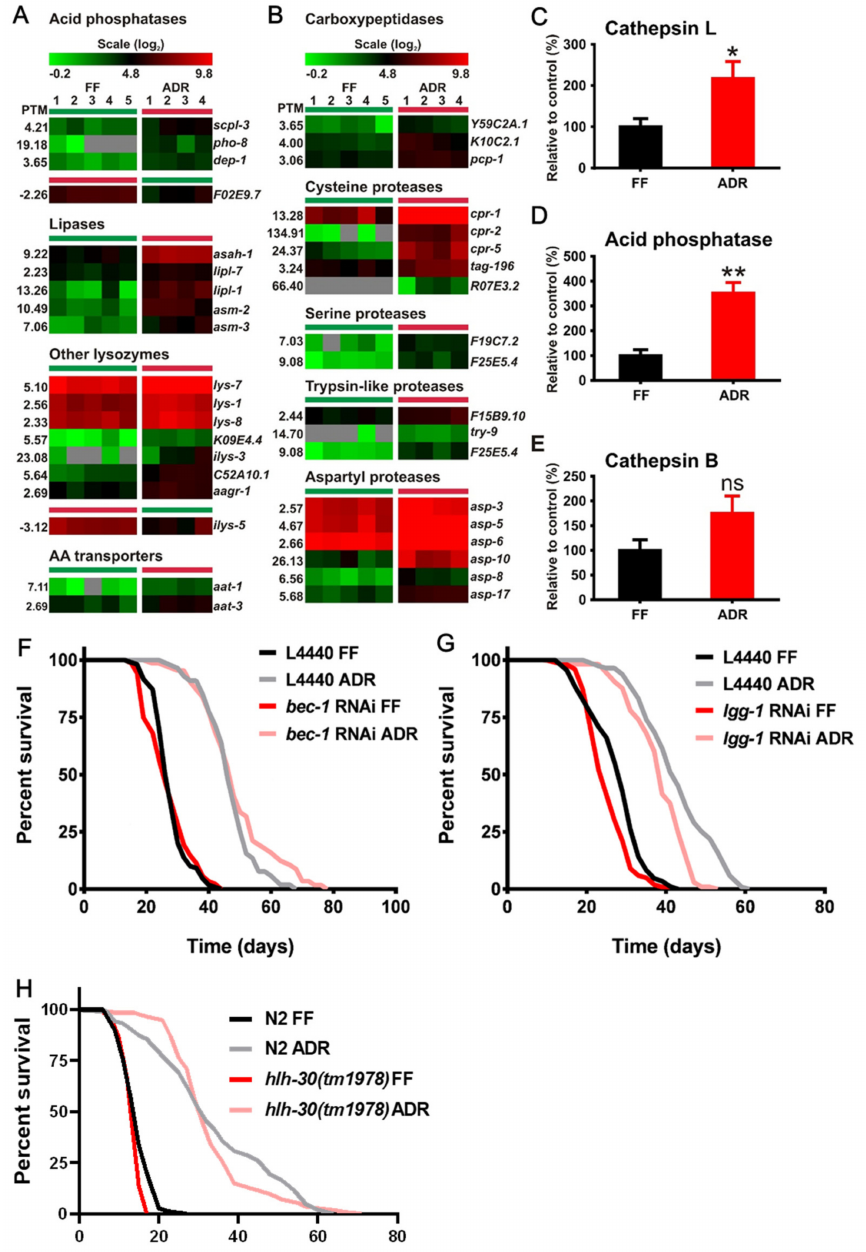
Figure 2. Lysosomal activity is increased in ADR worms. ( A ) Up-regulated expression of genes that encode for acid phosphatases, lipases, other lysozymes, and amino acid (AA) transporters. ( B ) Up- regulated expression of peptidase genes. Cathepsin L ( C ), acid phosphatase ( D ), and cathepsin B ( E ) I activity of FF and ADR worms. Survival analysis of worms with inhibited autophagy: bec-1 RNAi ( F ), lgg-1 RNAi ( G ), and hlh-30 ( tm1978 ) ( H ). L4440 = empty RNAi vector, FF = fully fed, ADR = axenic dietary restriction. PTM = Pavlidis template matching, * p < 0.05, ** p < 0.01, ns: not